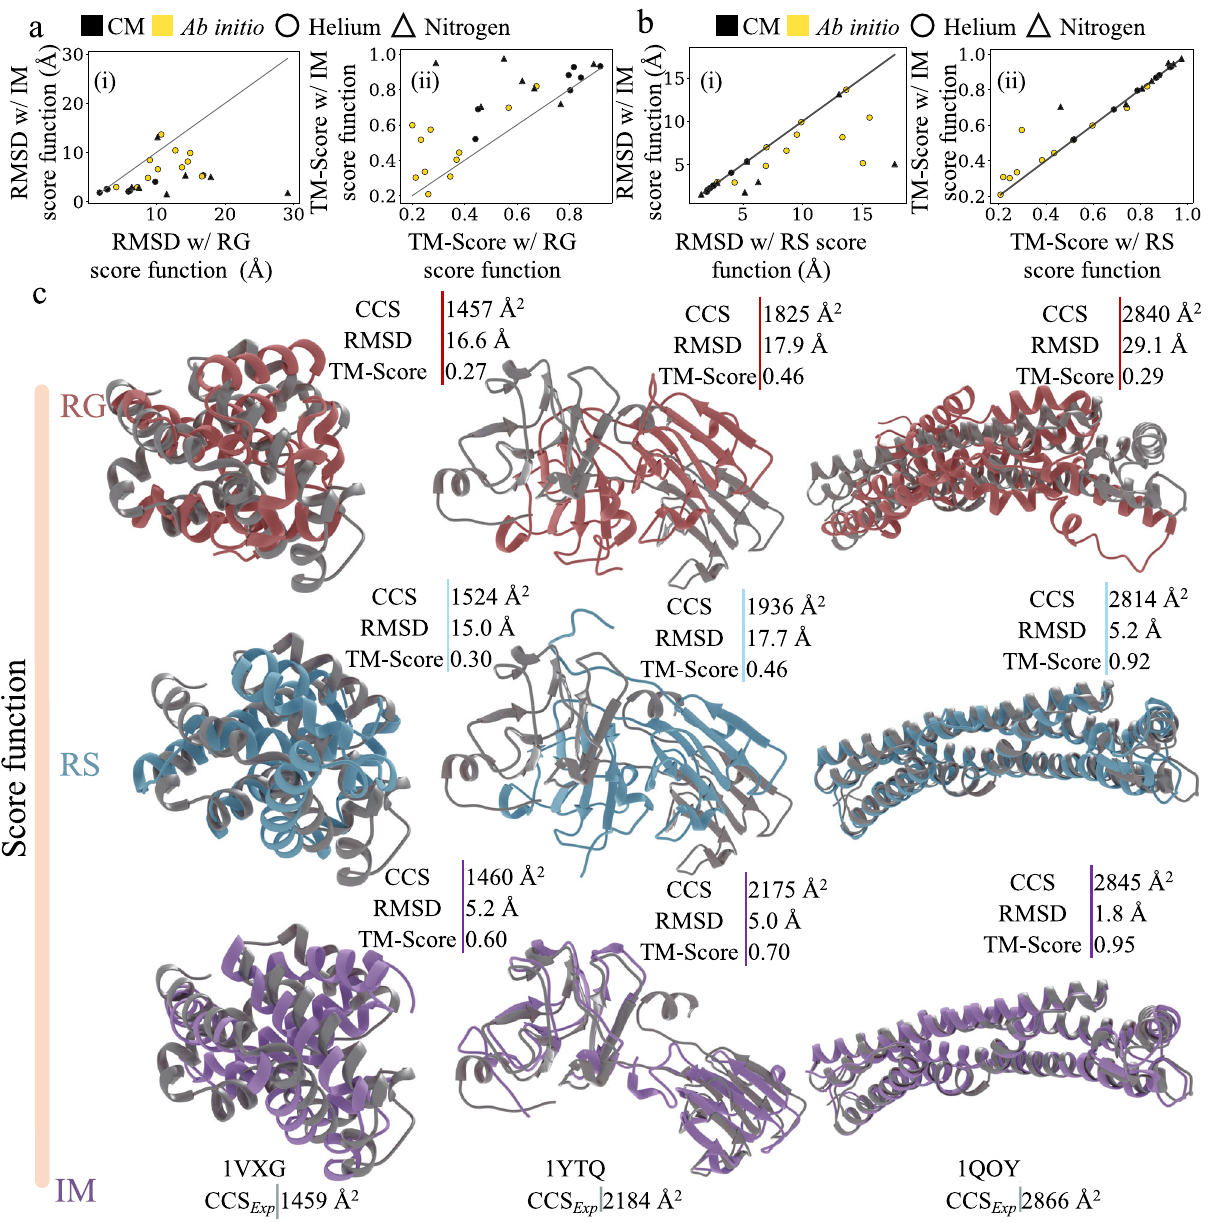
Fig. 4 | Protein structure prediction with and without experimental ion mobility(IMdata). ConsistentimprovementinmodelselectionusingtheIMscore functionwasobservedforthe25proteinswithexperimentalIMdata.Thepredicted models from the IM score function were compared to those of the a radius of gyration(RG)and b Rosetta(RS)scorefunctionsintermsoftheirrespective(i)root mean square deviation (RMSD) and (ii) template modelling score (TM-Score). For